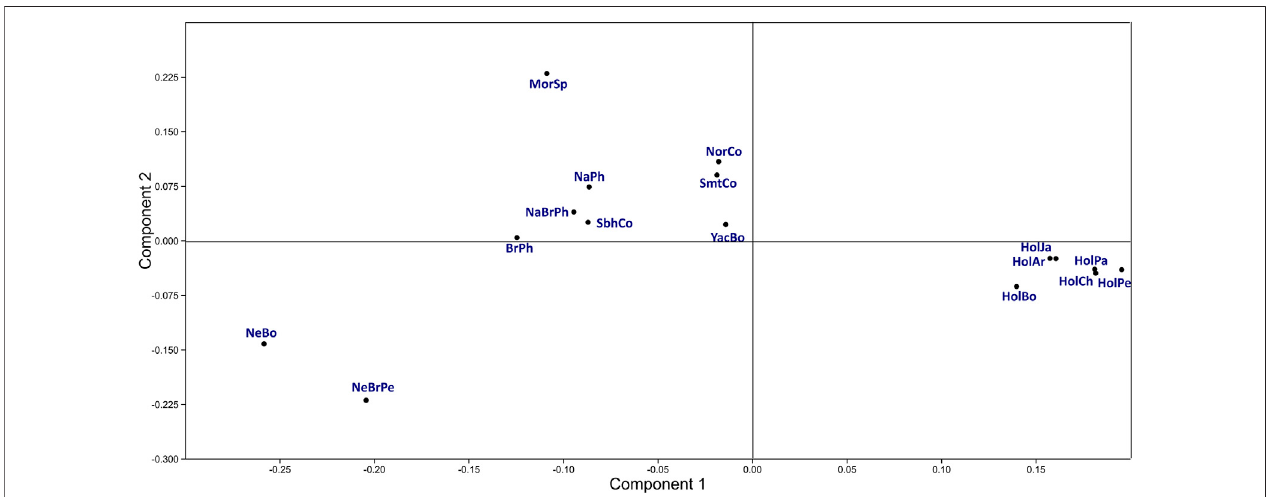
FIGURE 2 | Principal component analysis using BoLA-DRB3 allele frequencies for cattle